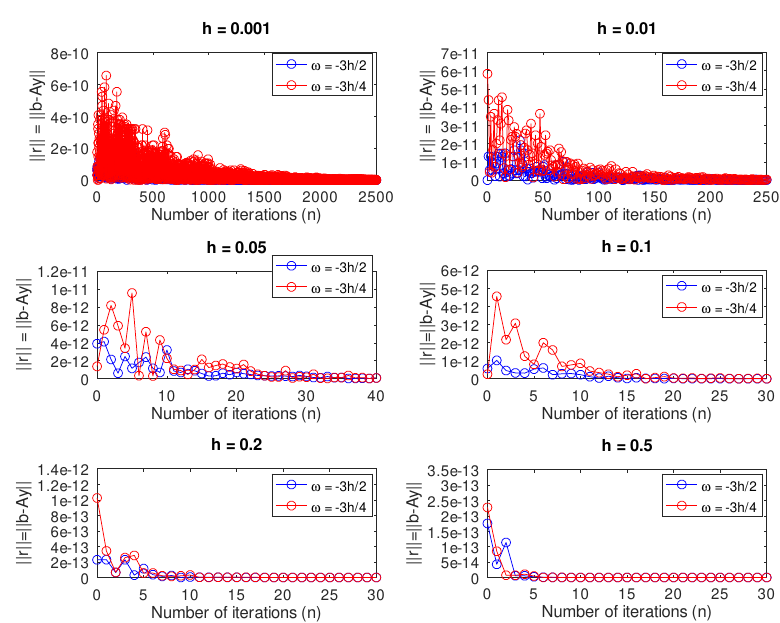
3 h . 2 − 3 h . 3 h 2 . − 2 −